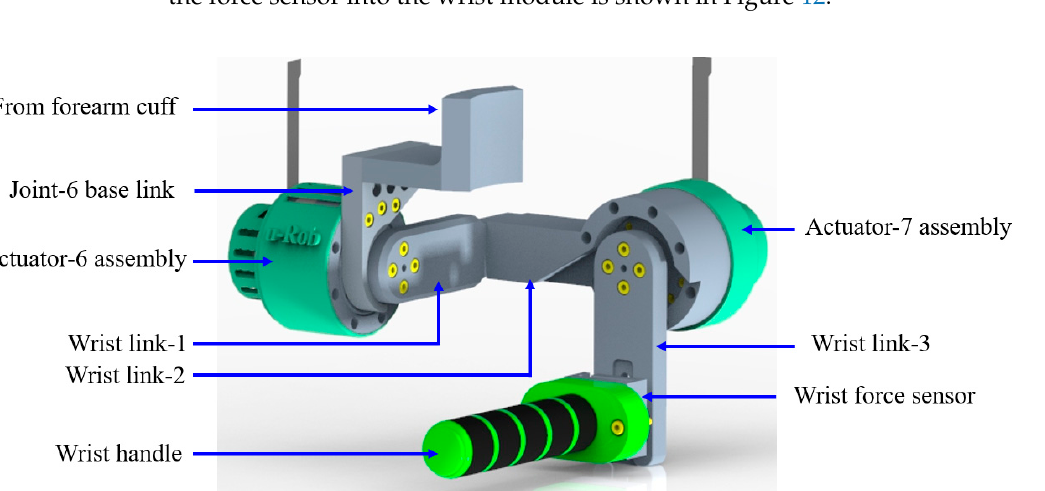
Figure 10. Forearm cuff assembly and its exploded view.